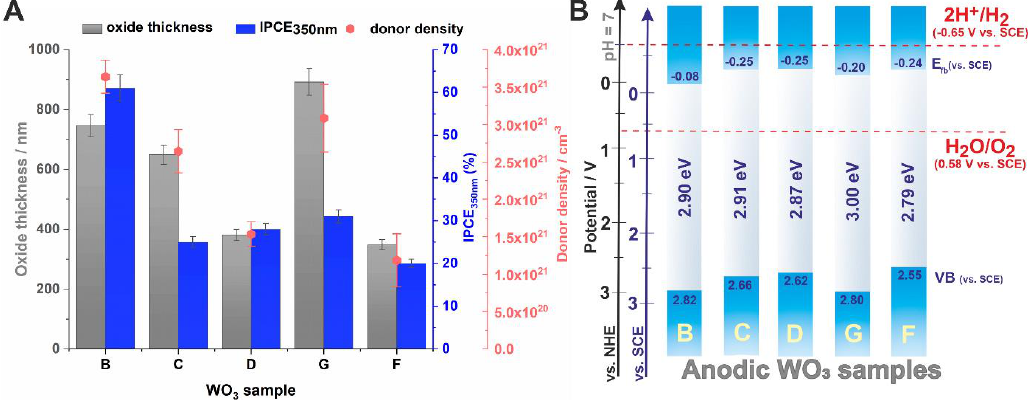
Figure 9. The correlation between oxide layer thickness, obtained IPCE value at 350 nm, and potential of 1 V vs. SCE and donor densities for anodic WO 3 materials ( A ). Energy diagrams for all tested anodic WO 3 samples (B ).